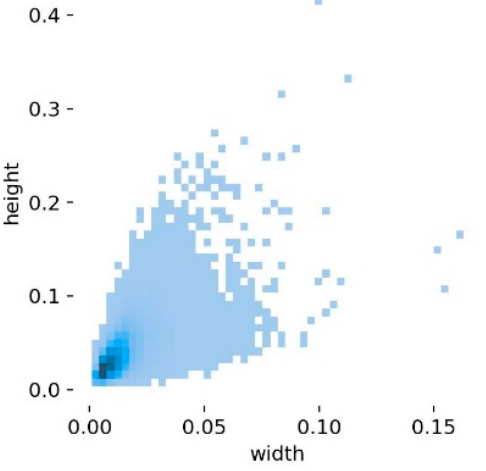
Figure 5. Label size distribution of the training set.